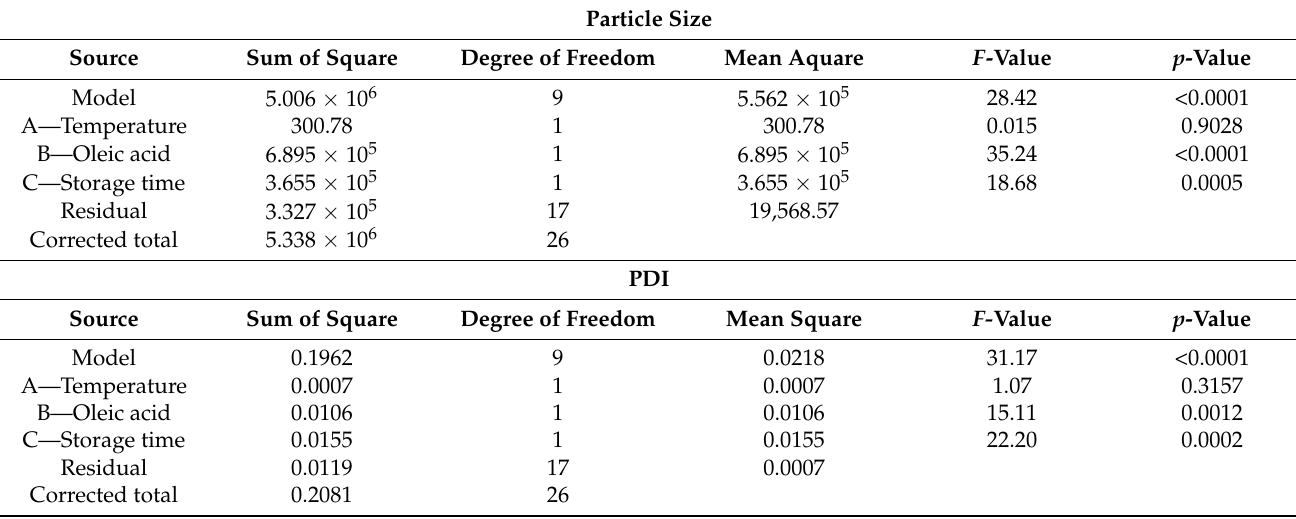
Table 4. Analysis of variance for the particle size and PDI of SBH NEs’ response surface quadratic